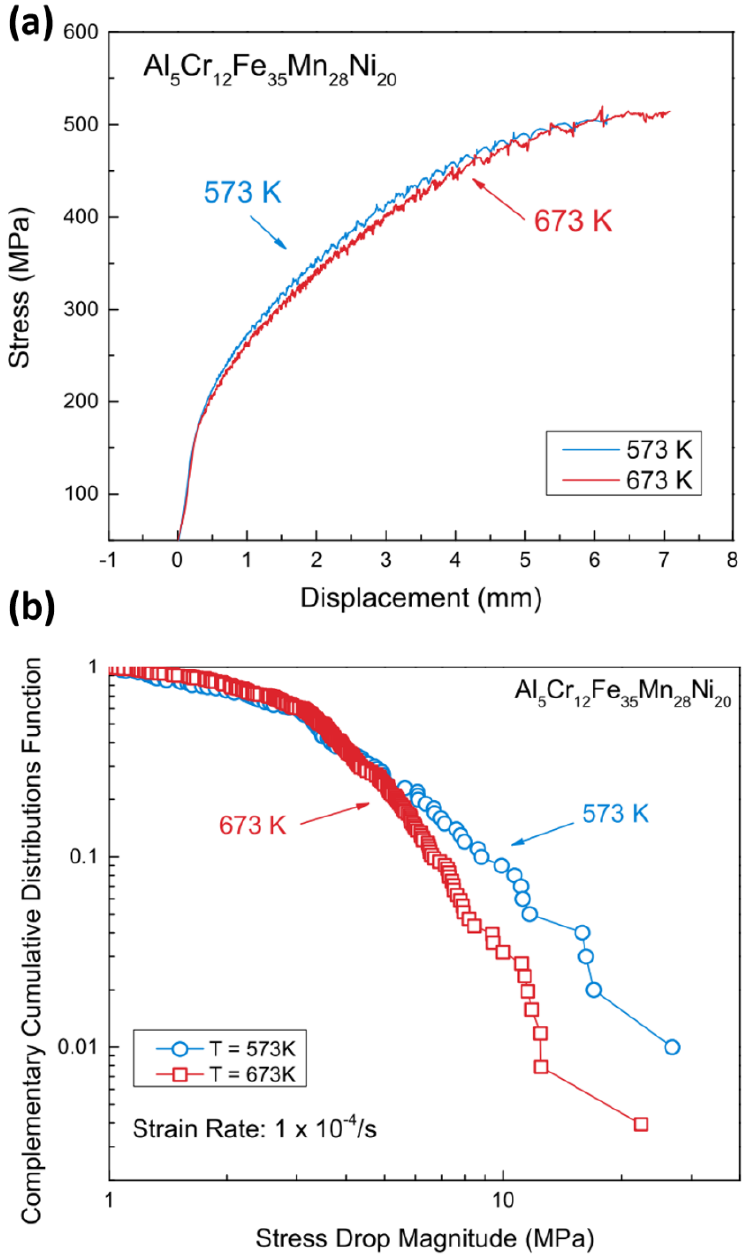
Figure 33. ( a ) Stress vs. displacement curves for the Al 5 Cr 12 Fe 35 Mn 28 Ni 20 HEA tension tested at temperatures of 573 and 673 K, at a strain rate of 1 × 10 − 4 s − 1 and ( b ) the results of the CCDF analysis for the serration events for the Al 5 Cr 12 Fe 35 Mn 28 Ni 20 HEA in tension experiments under a constant strain rate of 1 × 10 -4 s -1 (reproduced from Reference [167] with